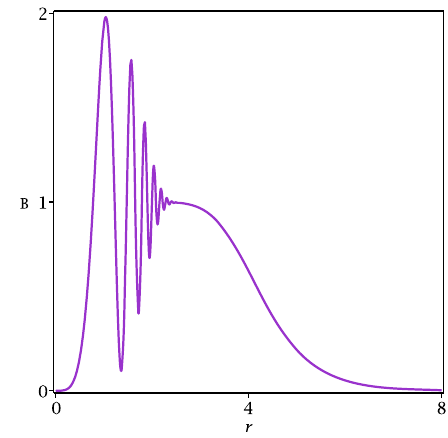
Fig. 11 Magnetic induction B 3 ( r ) , for a BPS solution of the model specified by (29). The topological charges are n 1 = 1, n 2 = 5, and n 3 = 10